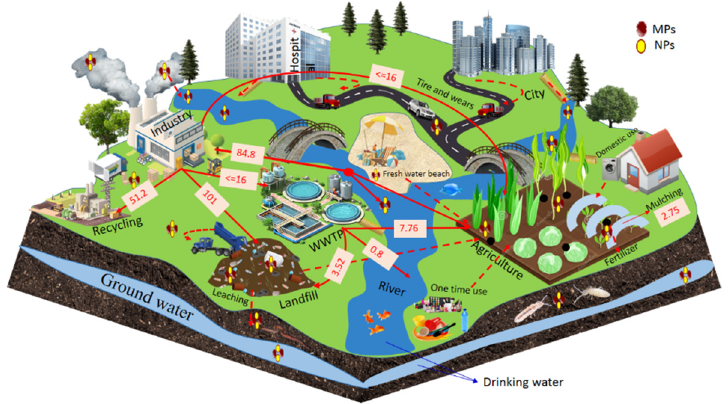
Figure 2. Estimates of plastic sources and transport pathways in the environment as reported in scientific literature; the data is indicated in million tons as well as the average data of high and low transportation in the ecosystem, arrows represent the known transportation and dashes represent unknown transportation in the ecosystem.